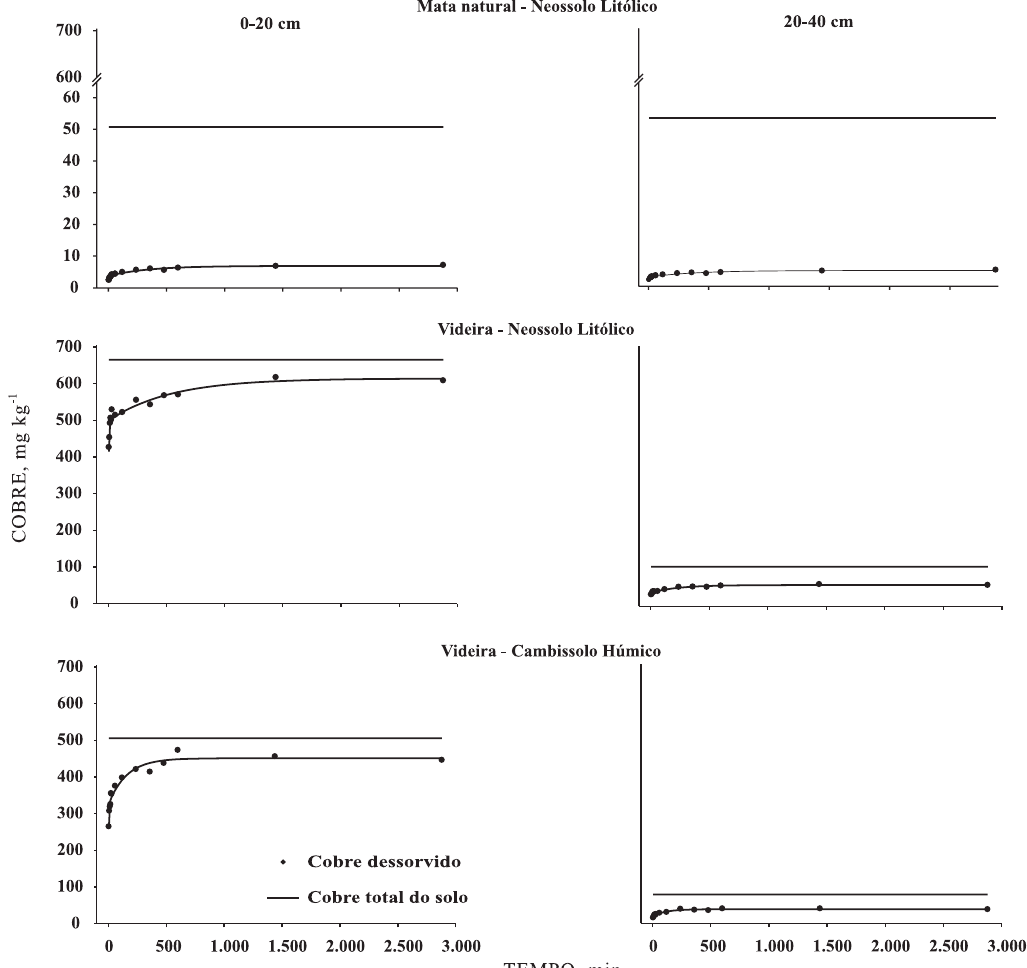
Figura 1. Dessorção de cobre pelo extrator EDTA 0,05 mol L -1 em pH 6,0, em função do tempo em um solo sob mata natural (Neossolo Litólico) e cultivado com videira (Neossolo Litólico e Cambissolo